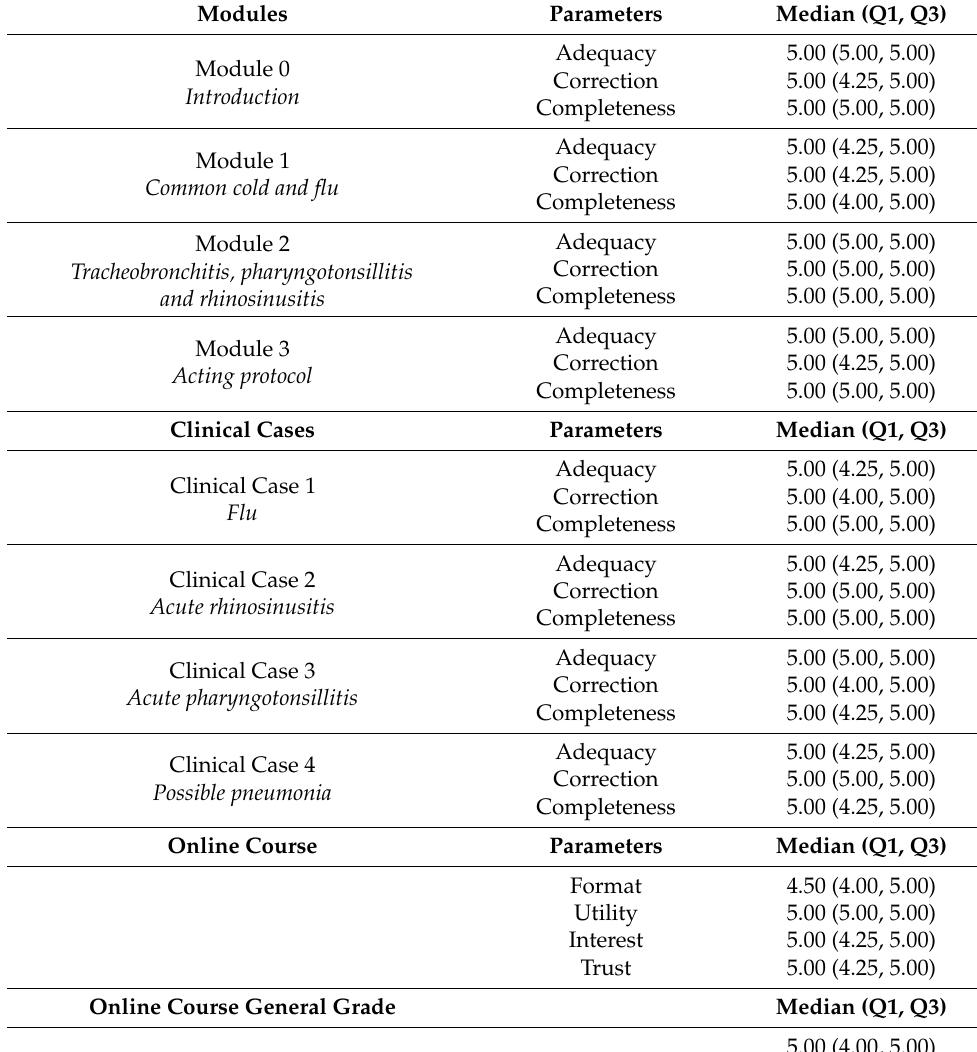
Table 2. Pharmacists’ quantitative evaluation of the overall parameters of the online course contents and clinical cases.